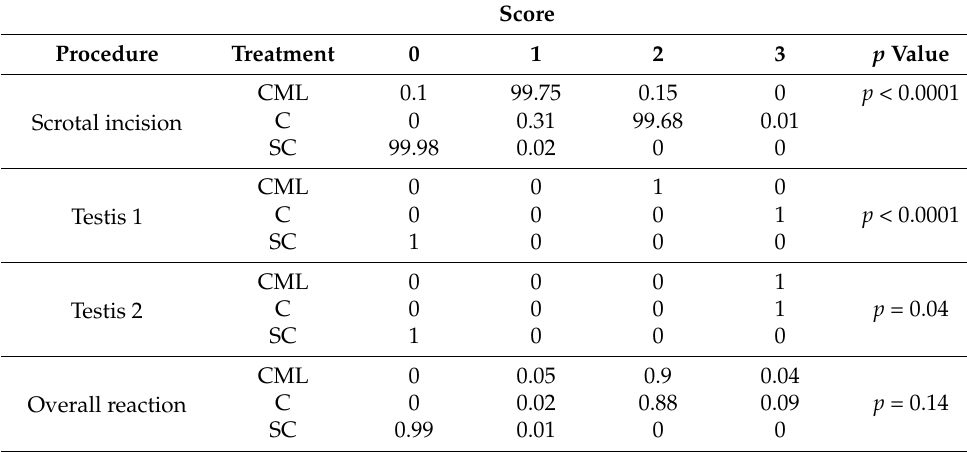
Table 4. Probability of lambs in different treatment groups (castration + analgesia (CML), castration (C), and sham control (SC) ( n = 8 for each treatment)) reacting to stages of castration—scrotal incision, removal of testis 1 (right), removal of testis 2 (left)—and overall reaction to castration procedure.